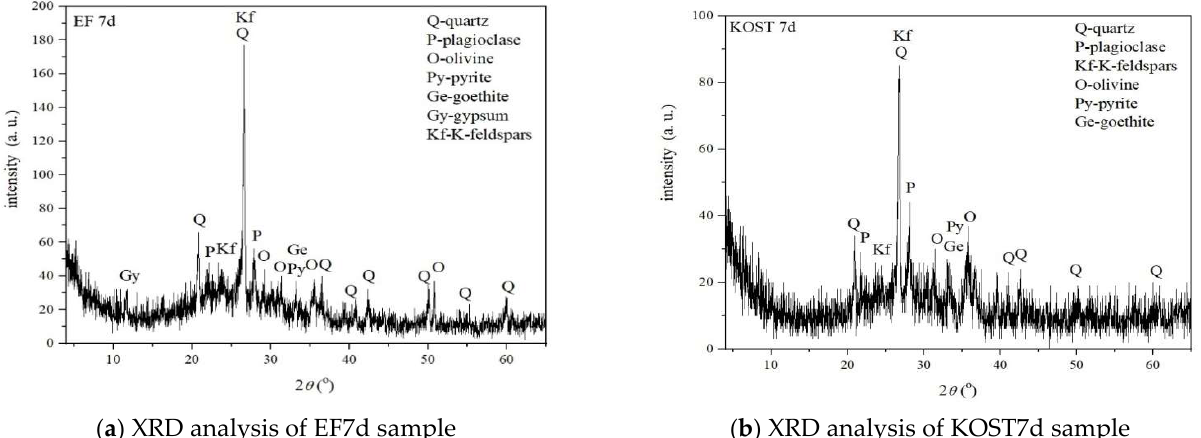
Figure 4. XRD analysis of EF7d and KOST7d fly ash samples.